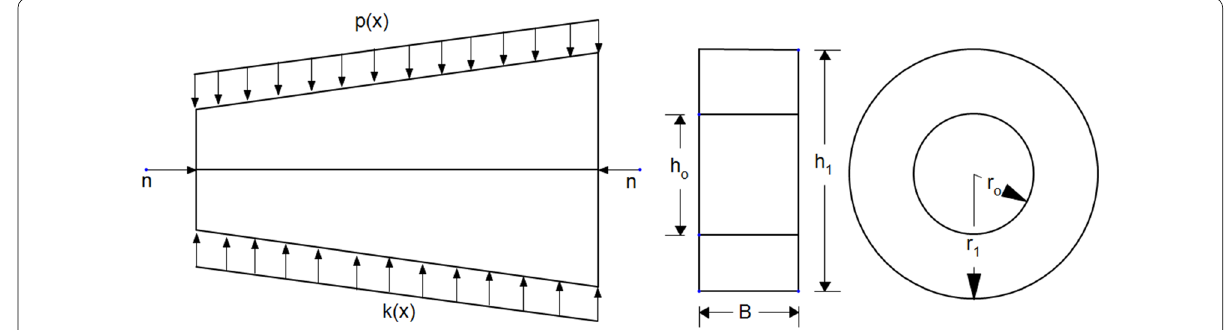
Fig. 1 Non-prismatic beam on an elastic foundation subjected to axial and transverse loads—rectangular and circular cross